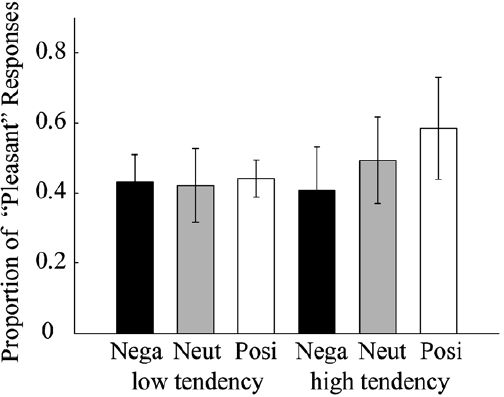
Figure 3. Proportion of ‘‘pleasant’’ responses as a function of prime valence and misattribution tendency. Error bars represent the standard deviation.